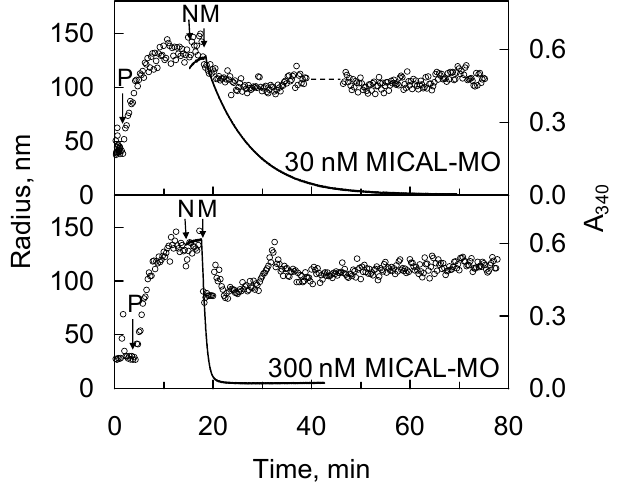
Figure 15. Monitoring the changes of the aggregation state of actin in solution in the presence of human MICAL-MO and NADPH by dynamic light scattering. Polymerization of G-actin (5 µM) was induced by adding 1/10 volume of polymerization buffer (P) at 25 °C .The mean radius of the particles in solution was determined with a Dynapro MS/X instrument (Protein Solutions, Lakewook, NJ, USA) by acquiring signals every 15 s ( ○ ). NADPH (100 µM, N) and MICAL-MO (M, 30 or 300 nM) were added at the indicated times and the reaction was monitored by dynamic light scattering (DLS). Solid lines: oxidation of NADPH (100 µM) monitored at 340 nm under identical conditions. The A traces are offset to match the time of enzyme addition to the solution containing F-actin and NADPH in the DLS experiment. Reprinted from [70] with permission from